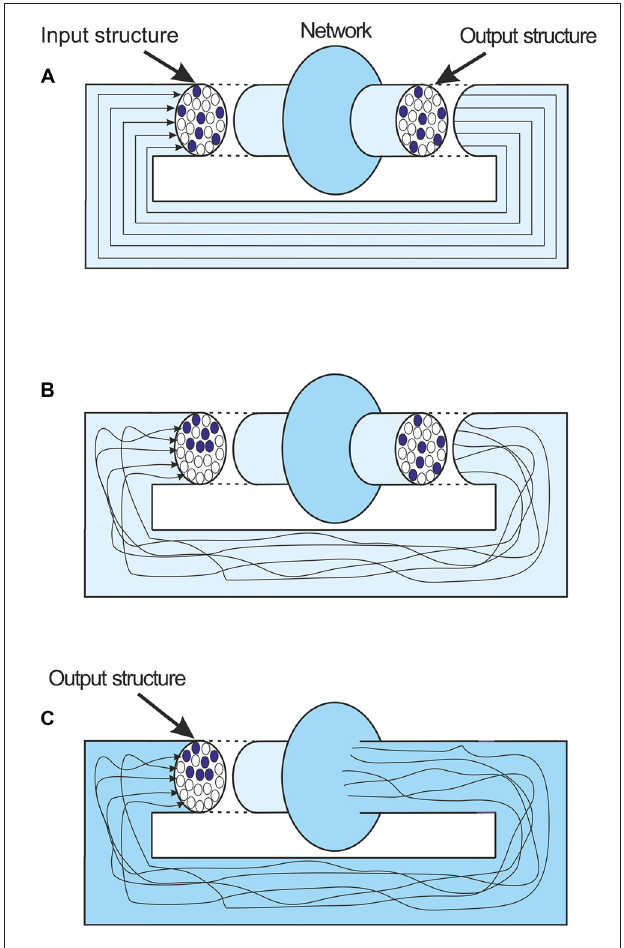
FIGURE 5 | (A) An idealized depiction of local feedback in a network. The output structure remains unchanged as it is fed back. (B) A more realistic depiction. Feedback axons follow convoluted paths and lead to an input structure that is quite different to the output structure. (C) The network boundary is extended to just before the fed back input. The output and the new input are now unchanged. Importantly the output is still a representation of the last message.